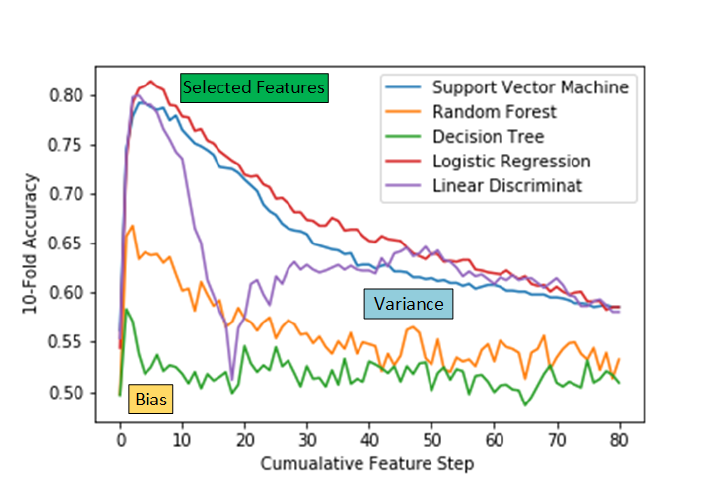
Figure 2. Comparison of Cumulative Feature Selection on the 10-Fold Accuracy.